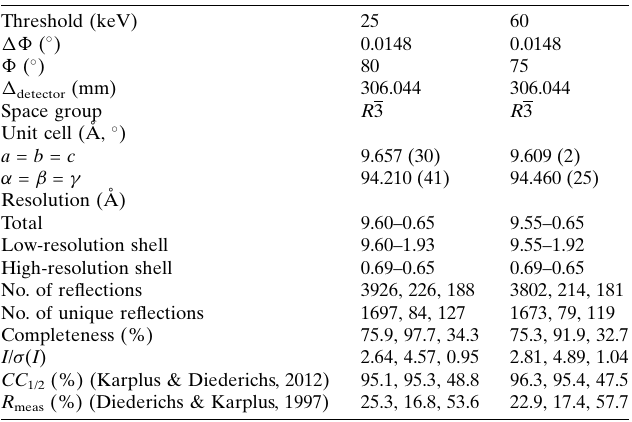
Table 2 Model statistics for SAPO-34.